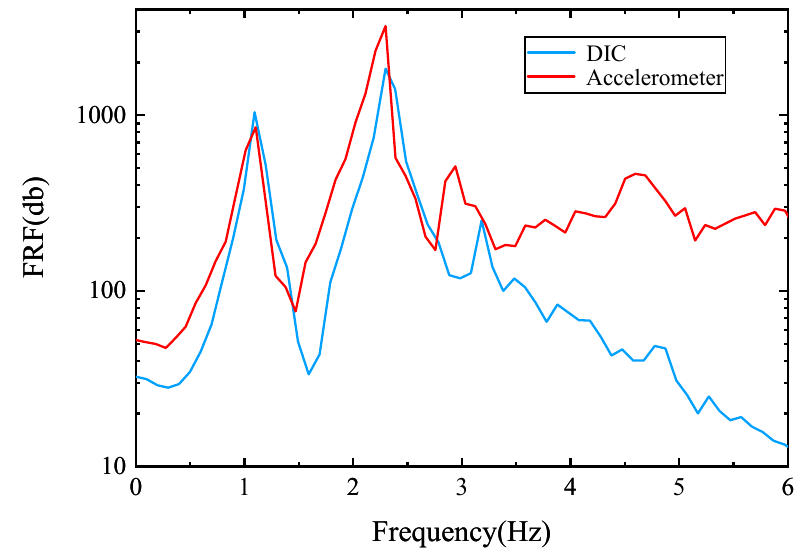
Figure 5. Frequency response function diagram.